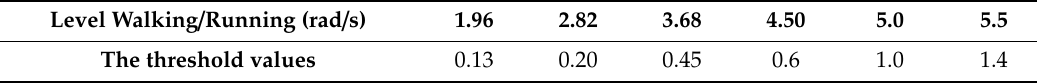
Table 1. The optimal thresholds of di ff erent motion modes.